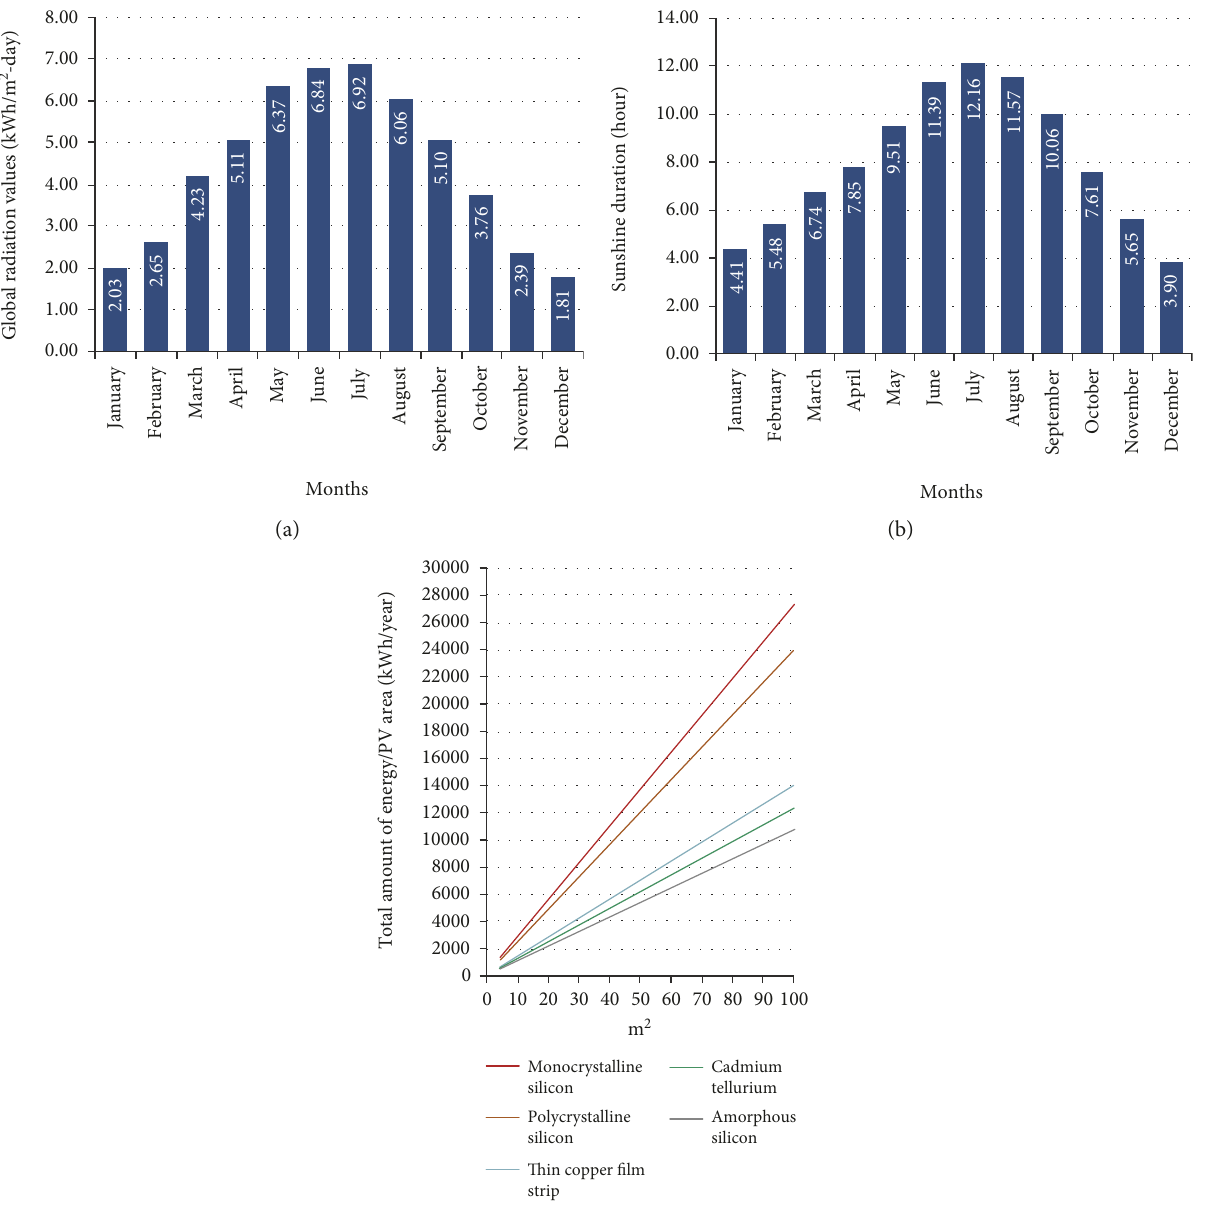
Figure 3: Ni ğ de province (a) global radiation values, (b) sunshine duration, and (c) total amount of energy/PV